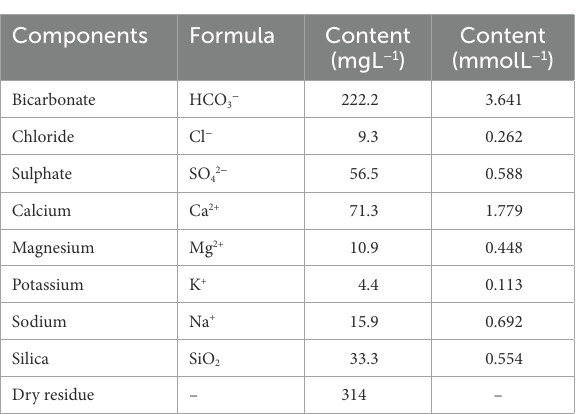
TABLE 2 Mineral water chemical